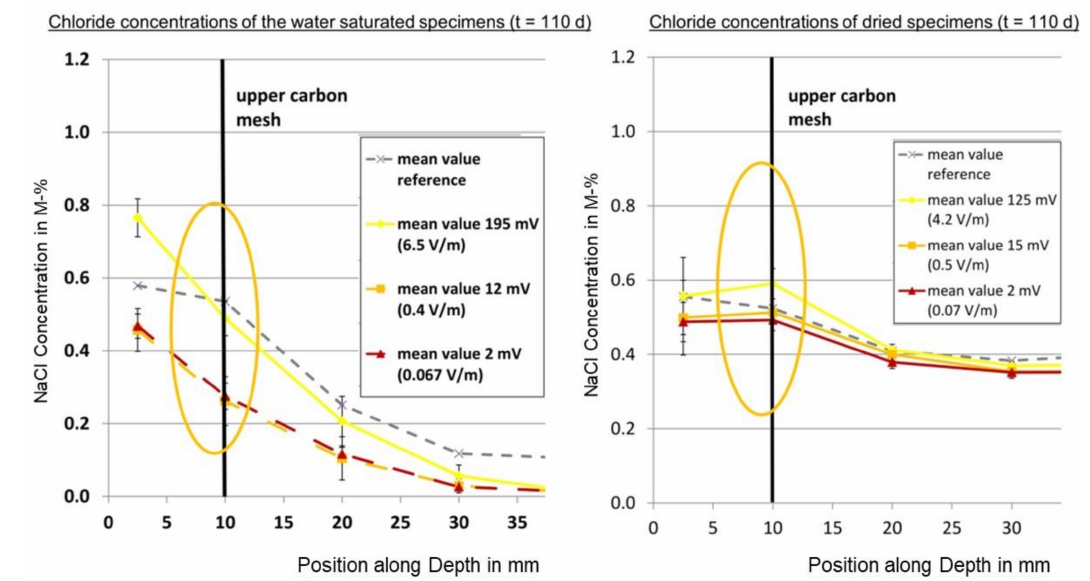
Figure 19. Investigated effect in the experimentally determined chloride concentration for t = 110